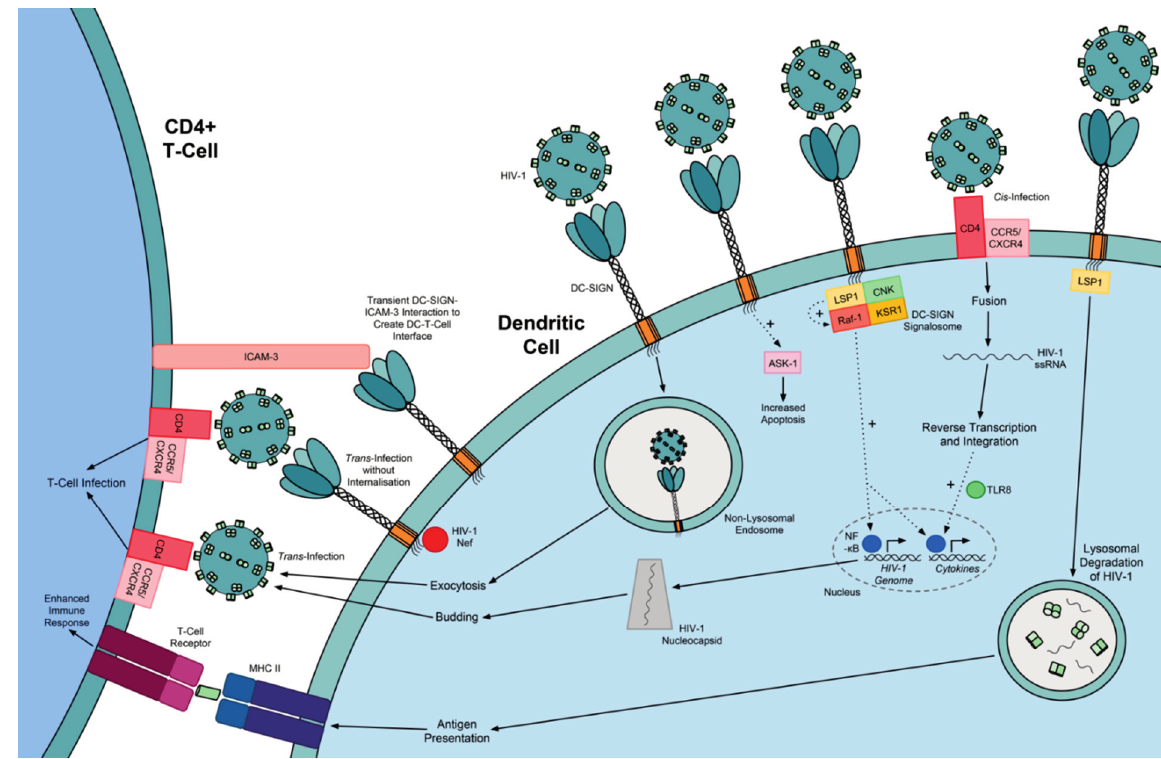
Figure 6. The role of DC-SIGN in HIV-1 infection. DC-SIGN neutralises HIV-1 infection through increased DC-SIGN signalosome-mediated cytokine production and degradation of virions. DC-SIGN then aids dendritic cell-T-cell interaction through transient ICAM-3